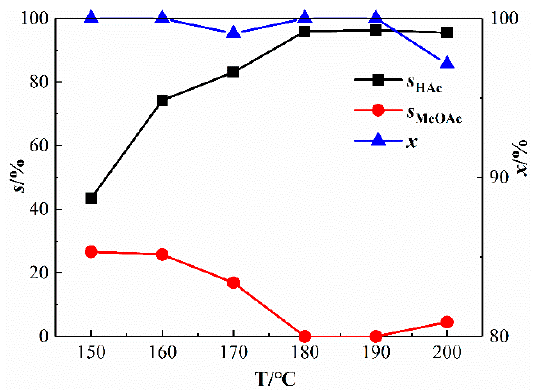
Figure 11. Catalytic performance of Rh(I)/Ru(III) bimetallic catalysts at different temperatures ( p = 3.5 MPa; t = 60 min; w(CH 3 COOH) = 54 wt%; w(H 2 O) = 6 wt%; x /%: conversion rate of methanol).